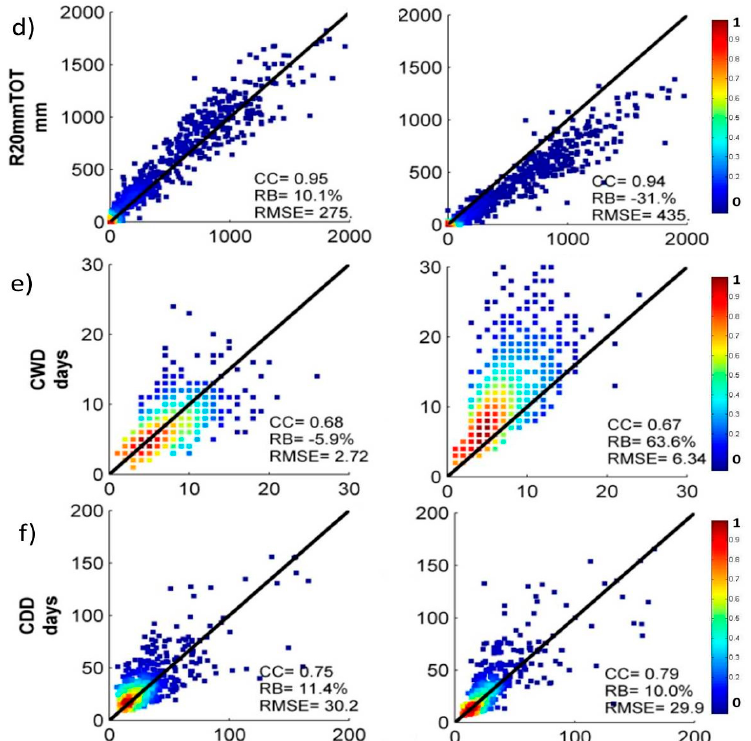
Figure 8. Density-colored scatterplots of six extreme precipitation indices for two satellite-based products throughout China, ( a ) RR99P; ( b ) RR95P; ( c ) R20mm; ( d ) R20mmTOT; ( e ) CWD; ( f ) CDD. The dark solid line is the 1:1 line. As in Figure 5, the color represents the occurrence possibility and red indicates more points that are located in that domain.